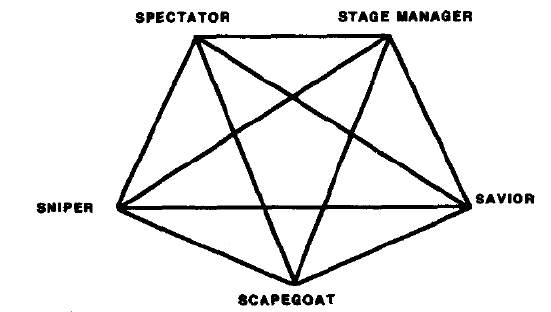
Figure 4: Game Pentagon (Summerton, 1992, p.69)